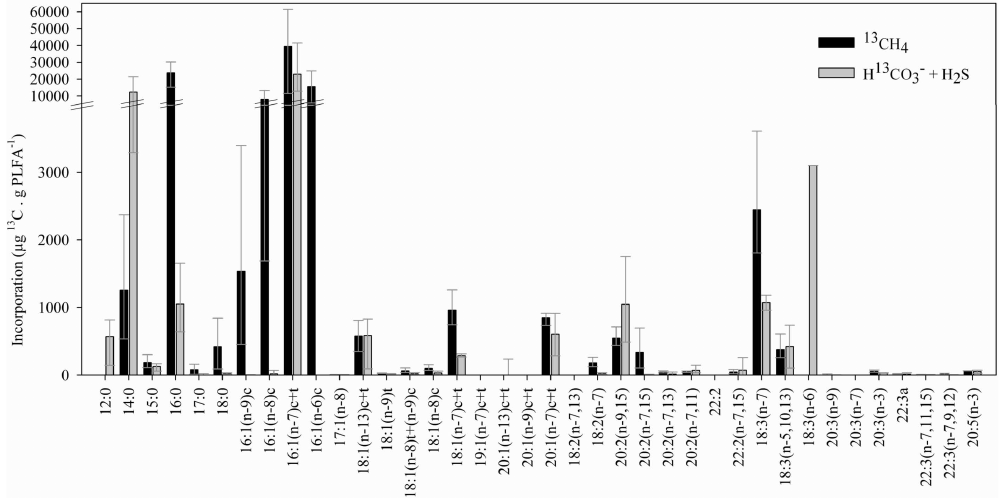
Fig. 2. Bathymodiolus azoricus gill tissue PLFA ( n = 3, average ± min-max) 13 C incorporation per total PLFA content (as calculated using Eq. 3) after a 15 day supply with 13 CH 4 (black bars), or a 20 day supply with H 13 CO −